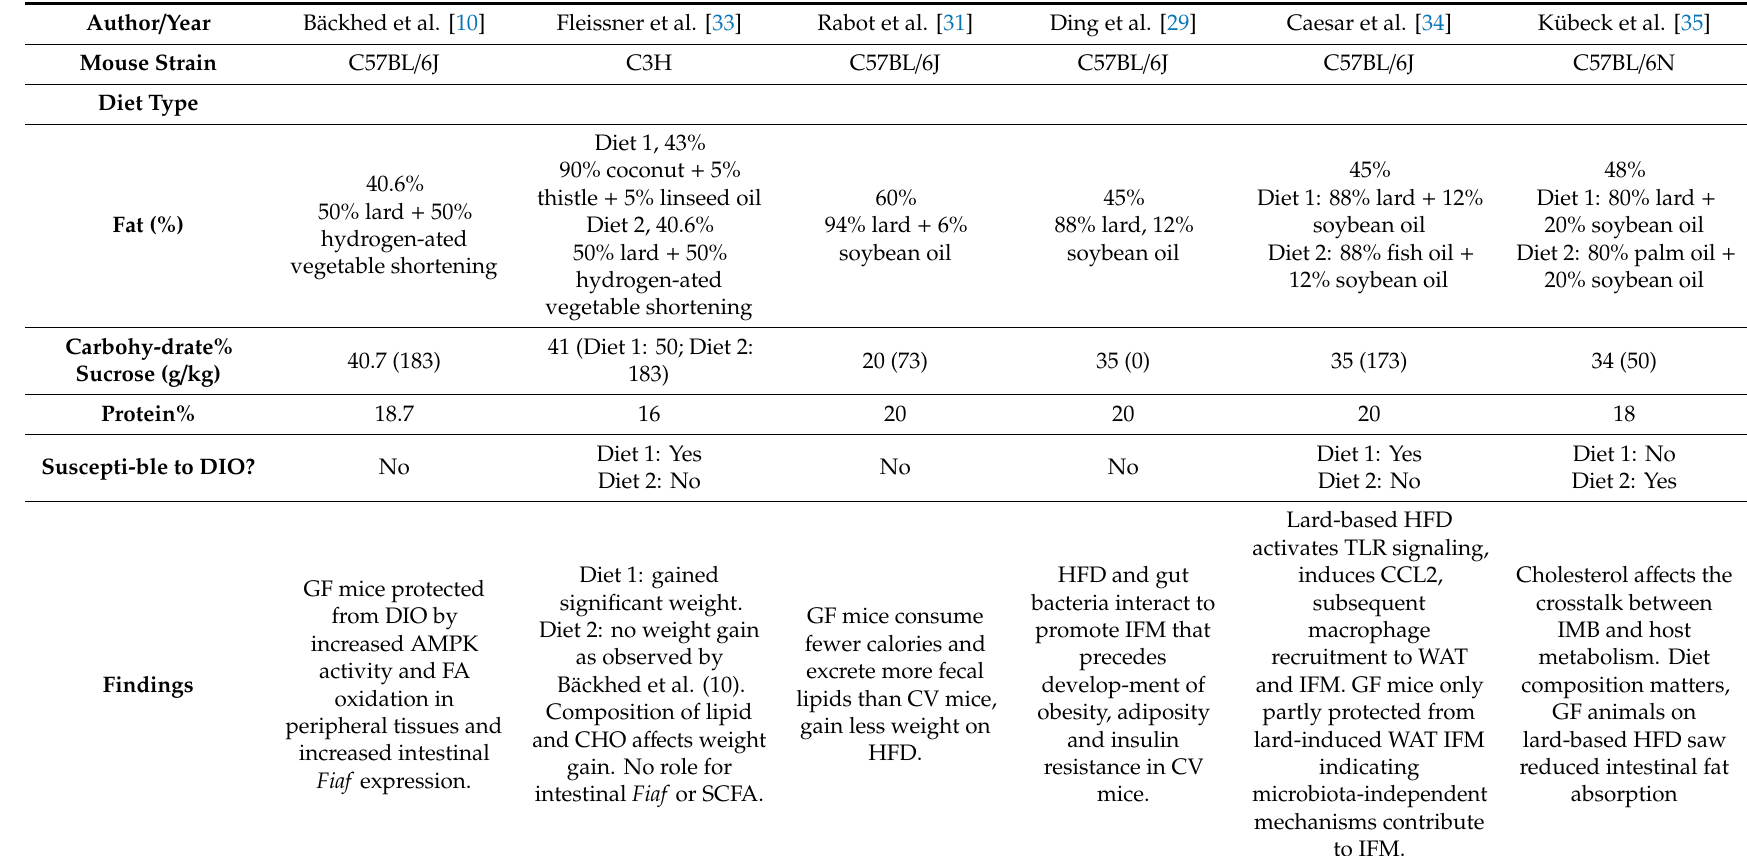
Table 1. Summary of diet-induced obesity (DIO) in germ-free (GF)